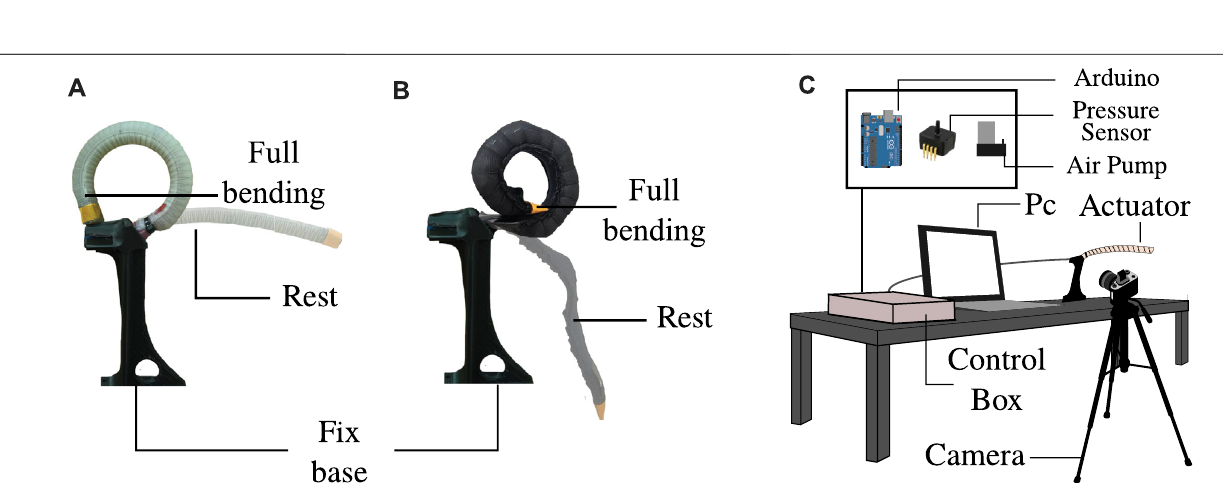
Frontiers in Bioengineering and Biotechnology |